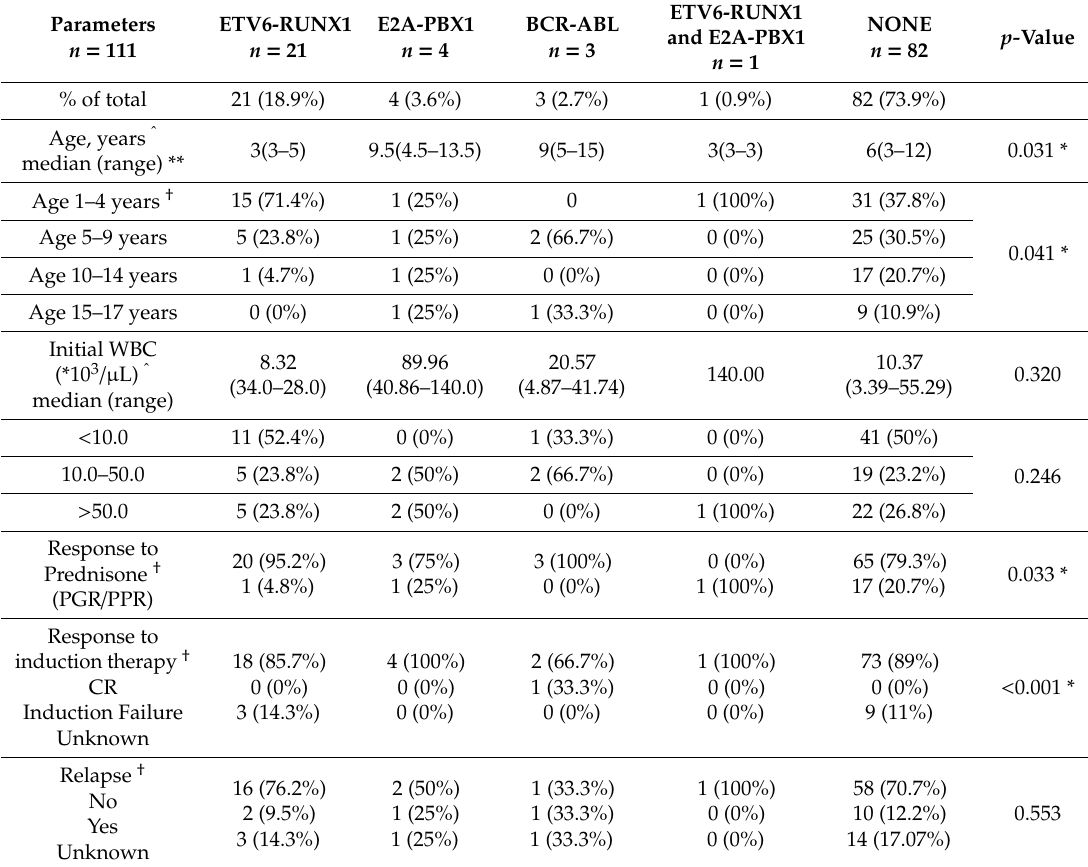
Table 3. Molecular subgroups and other parameters at diagnosis, as well as during and after treatment.